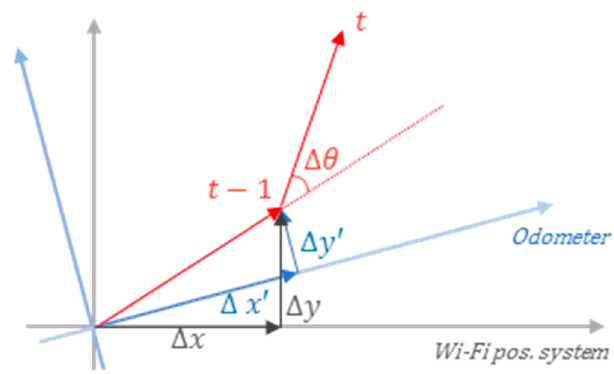
Figure 7. Changes in the coordinates of the odometer and Wi-Fi positioning system according to the robot movements.